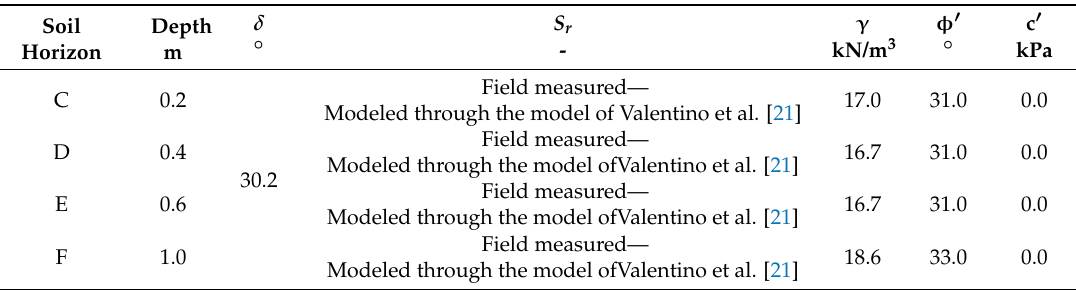
Table 5. Input data for the F s